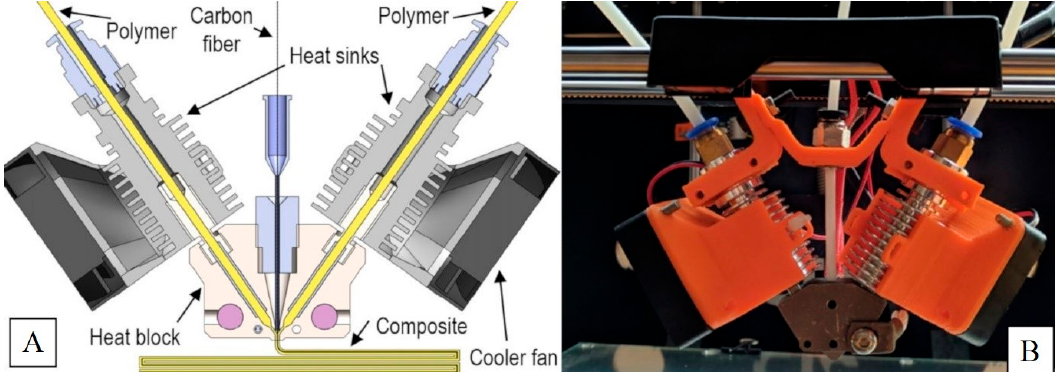
Figure 1. ( A ) Diagram of the extrusion head with symmetrical feeding of matrix material and ( B ) the made prototype.